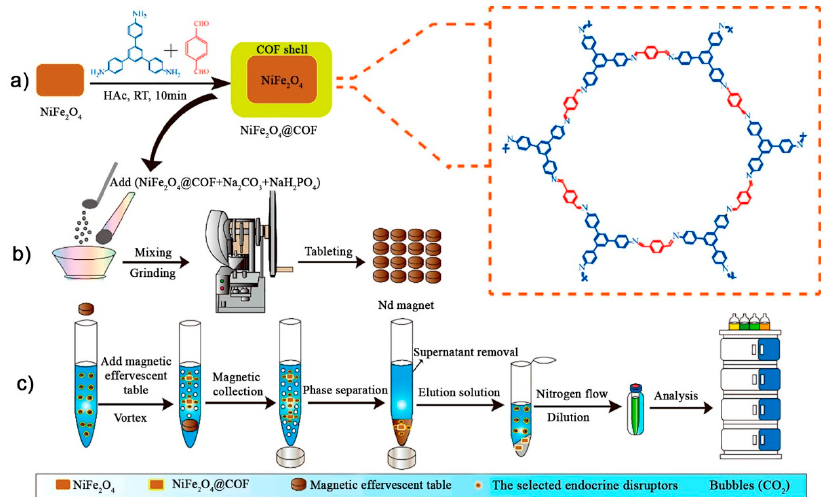
Figure 19. Schematic diagram of the ERME method: ( a ) synthesis of TAPB-TPA-coated NiFe 2 O 4 composite, ( b ) preparation of the magnetic effervescent tablets, ( c ) pre-concentration and analytical analysis of endocrine disruptors. (Adapted with permission from reference [24], copyright 2020, Elsevier).